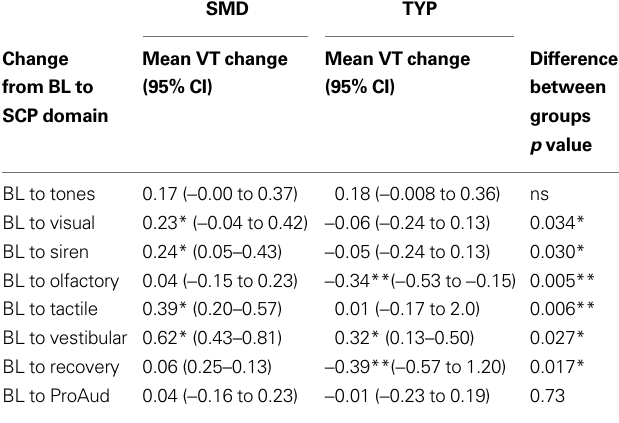
Table 2 | Difference in vagal reactivity between SMD and TYP change score (95% CI).